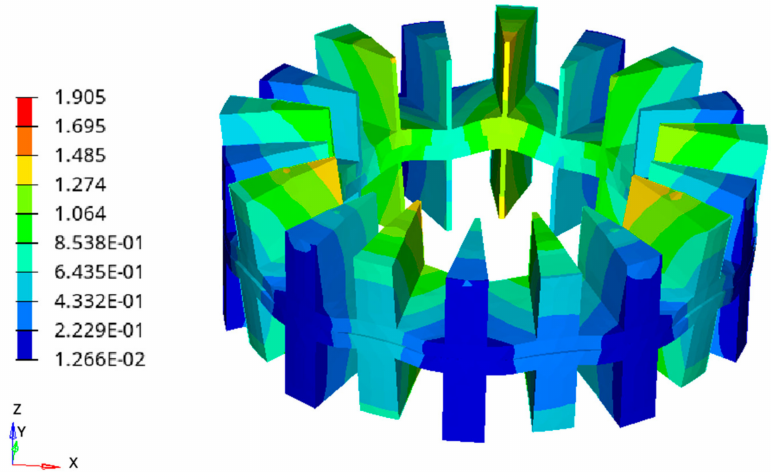
Figure 13. The deformed geometry’s velocities (mm/s) of the stator core at 600 Hz.